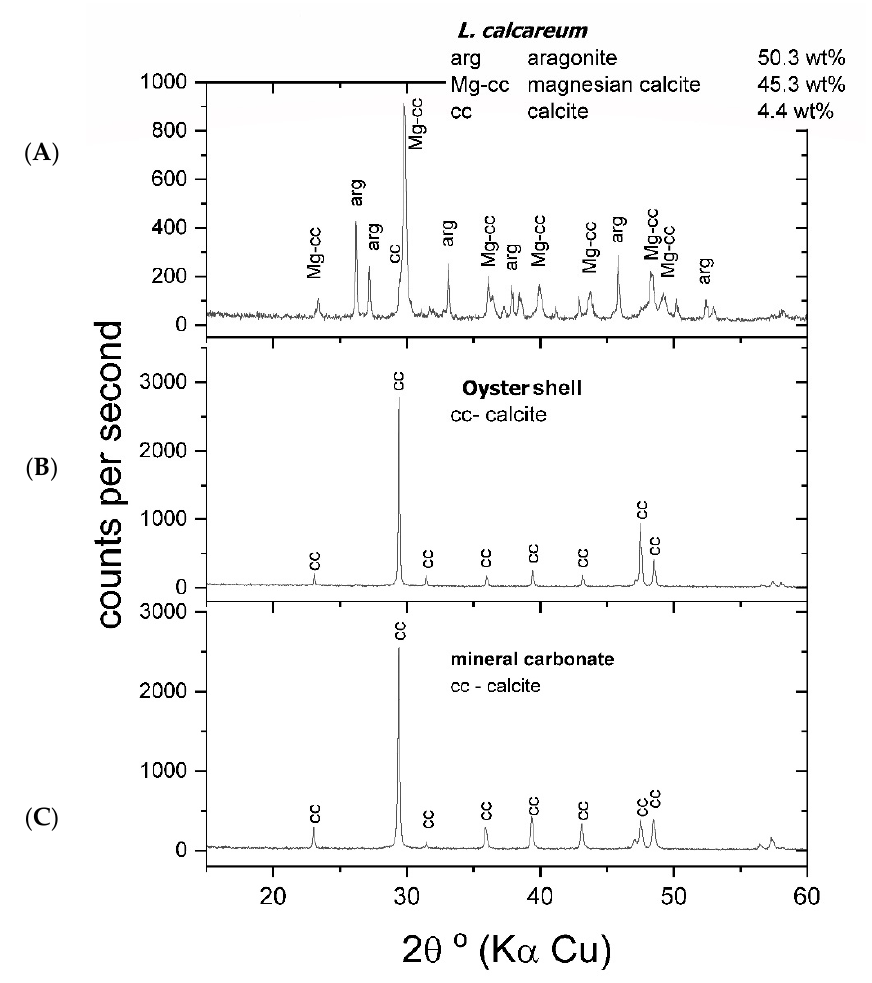
Figure 6. X ‐ ray diffractograms profile of CaCO 3 samples by the Rietveld method. In the refinement the theoretical density of the proportions distribution of the phases of L. calcareum ( A ) were arago ‐ nite: 2.94 g.cm − 3 , magnesian calcite: 2.84 g.cm − 3 and calcite: 2.74 g.cm − 3 . The theoretical density rec ‐ orded for inorganic mineral CaCO 3 ( B ) was 2.72 g.cm − 3 while for oyster shell CaCO 3 ( C ) it was 2.71 g.cm − 3 .